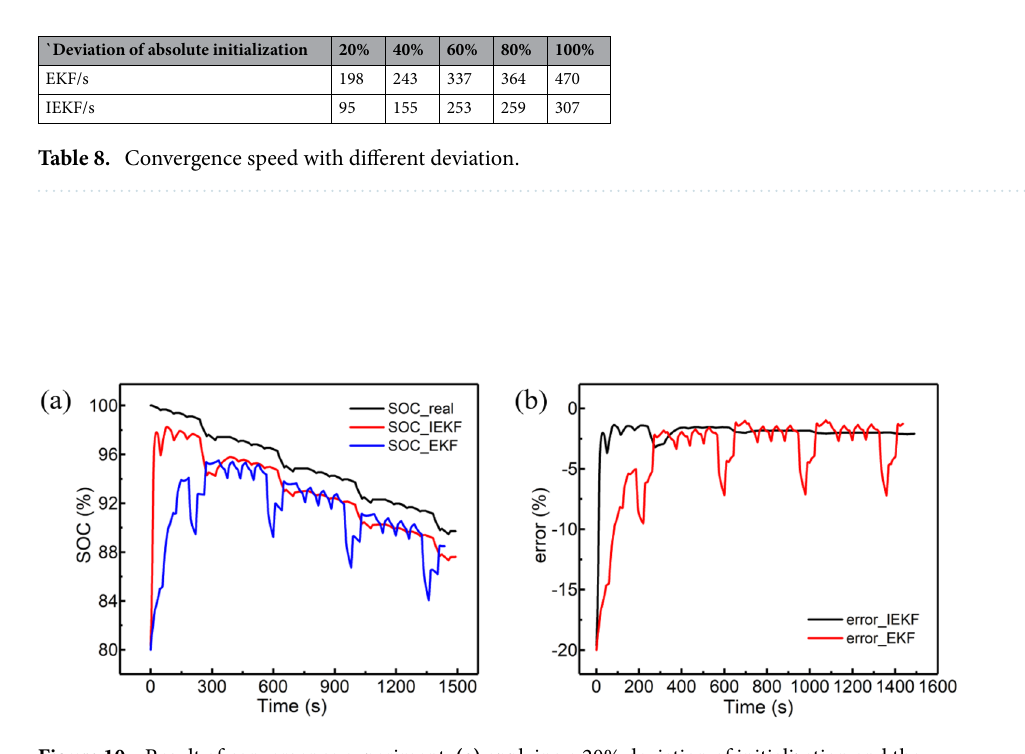
Figure 10. Result of convergence experiment: (a) applying a 20% deviation of initialization and the convergence of SOC; (b) error